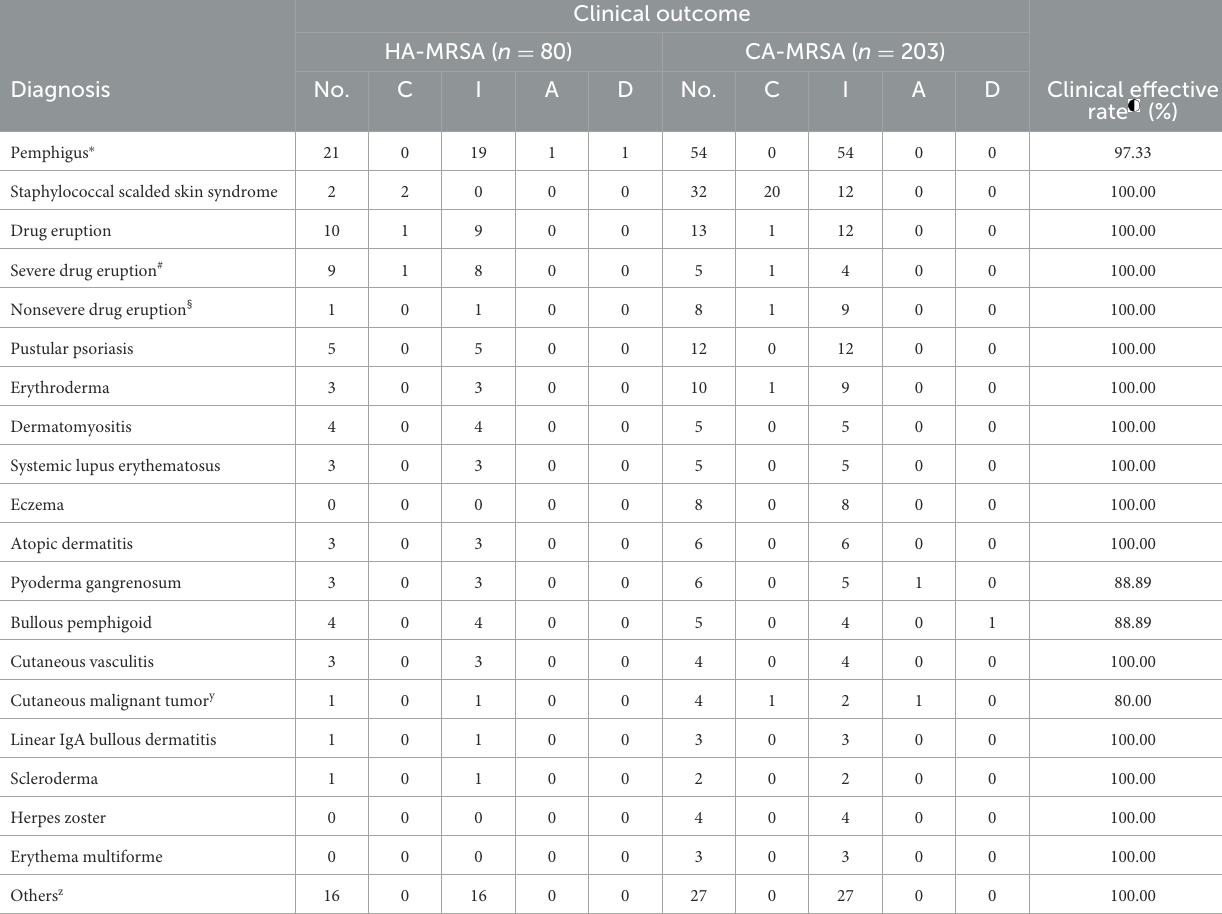
TABLE 5 Clinical outcome associated with skin and soft tissue healthcare-associated methicillin-resistant S. aureus (HA-MRSA) and community-associated methicillin-resistant S. aureus (CA-MRSA) infection from January 1, 2015 to December 31, 2021. Clinical